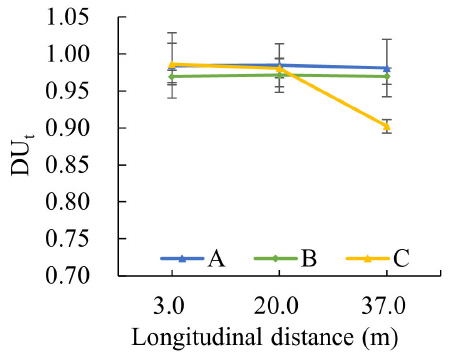
Figure 8. Longitudinal distribution uniformity in the test plots.